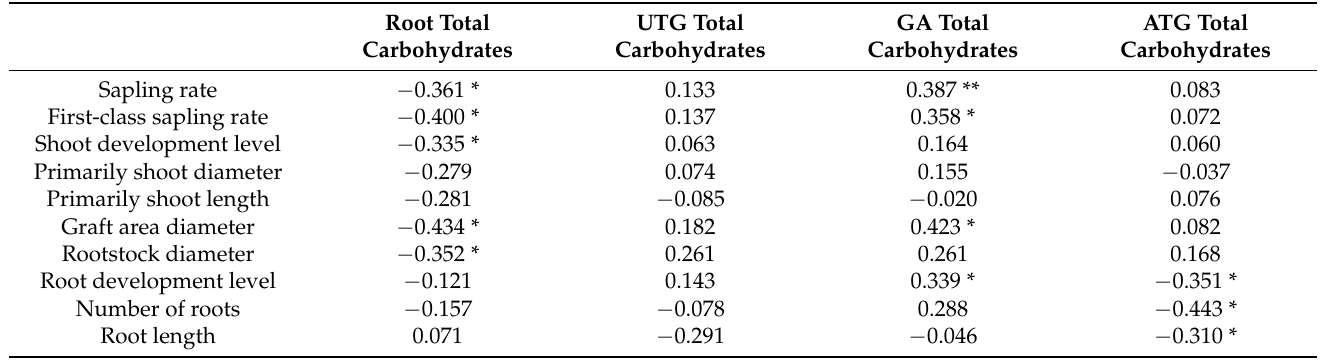
Table 4. Correlation between sapling rate criteria and carbohydrate